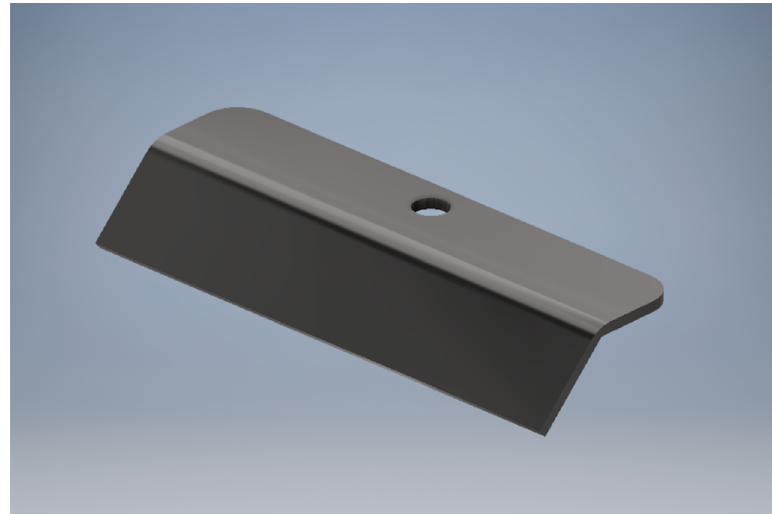
Figure 9. Bracket to secure battery.